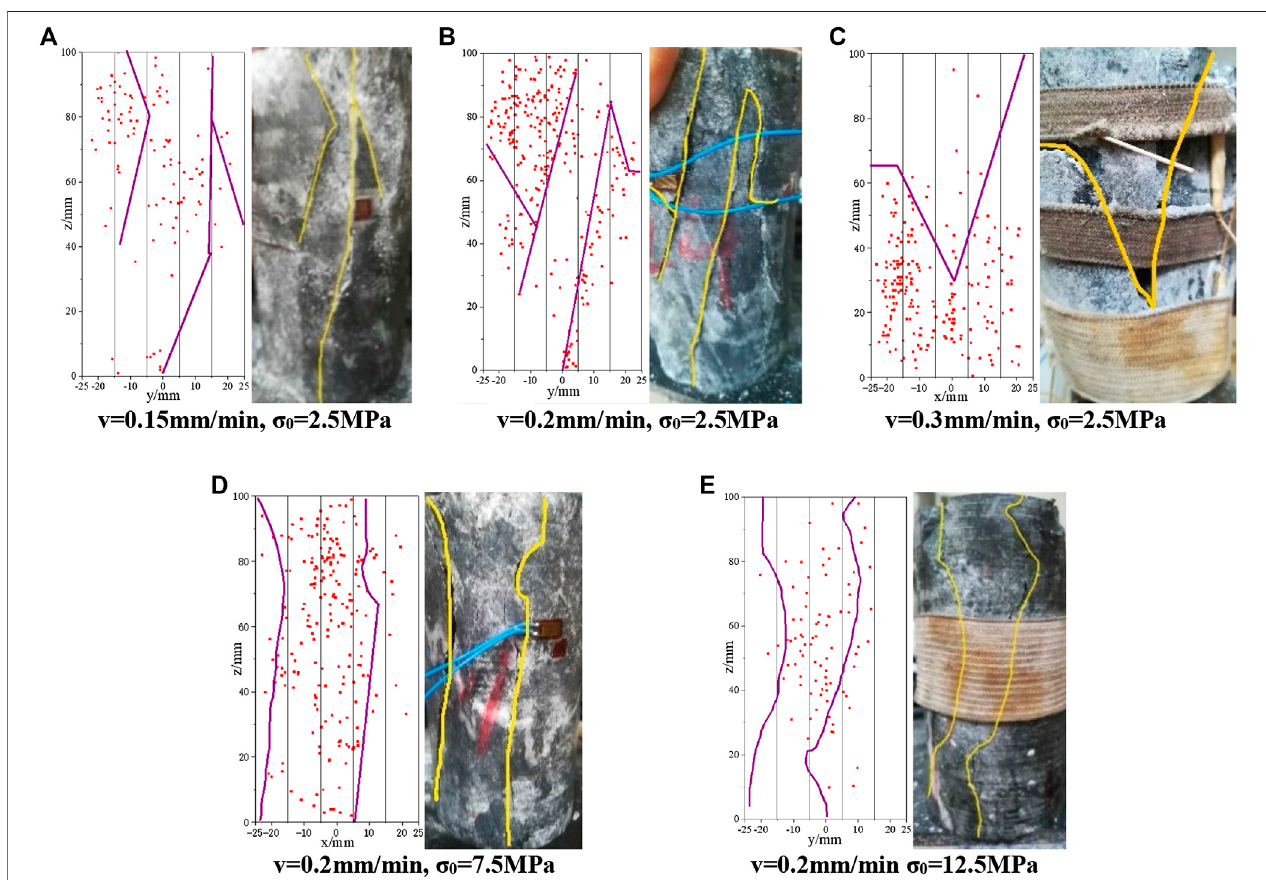
FIGURE 2 | AE event point source distribution and macroscopic failure structure of rock under different loading rates and initial stresses.